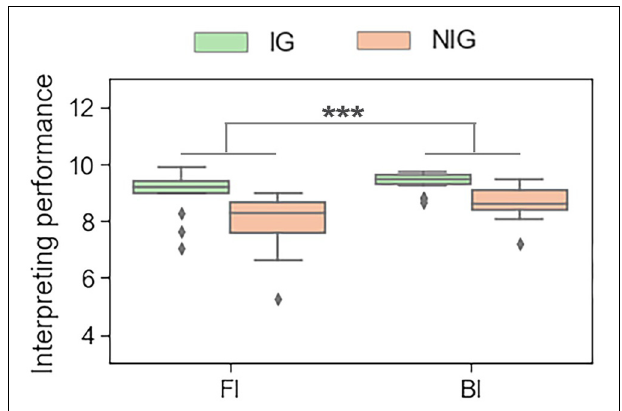
FIGURE 3 | The main effect of interpreting direction in interpreting trials in terms of the behavioral data. *** p < 0.001.